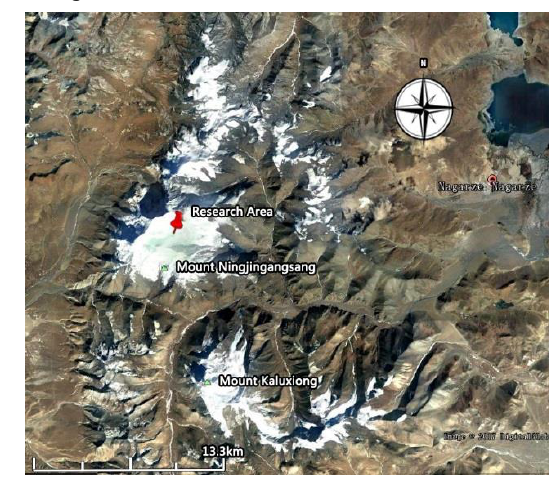
Figure 1. The location of research area